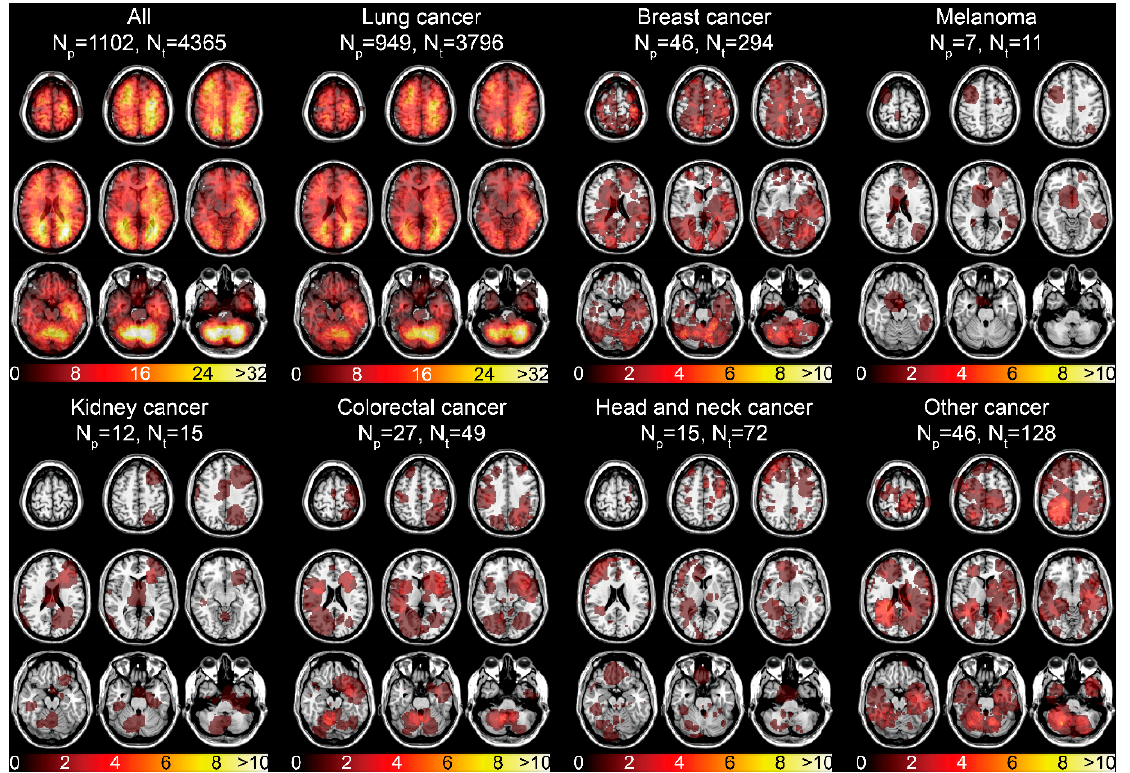
Figure 3. Tumor frequency heatmaps of BMs according to different primary malignancies. The numbers in the color bars refer to the number of BMs. N p refers to the number of patients. N t refers to the number of tumors.